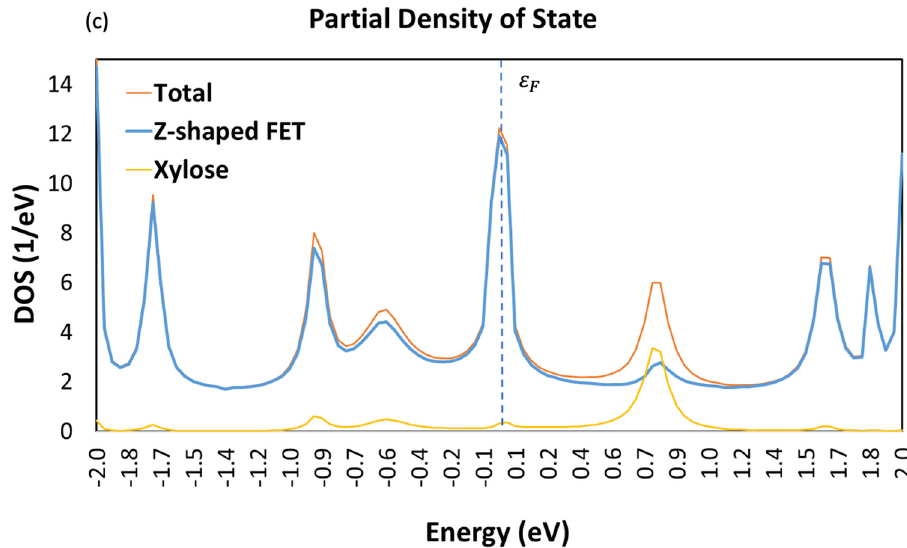
Figure 6. Total and partial density of states (DOS) of GNR-FET in the presence of ( a ) Glucose molecule; ( b ) Fructose molecule; and ( c ) Xylose molecule.